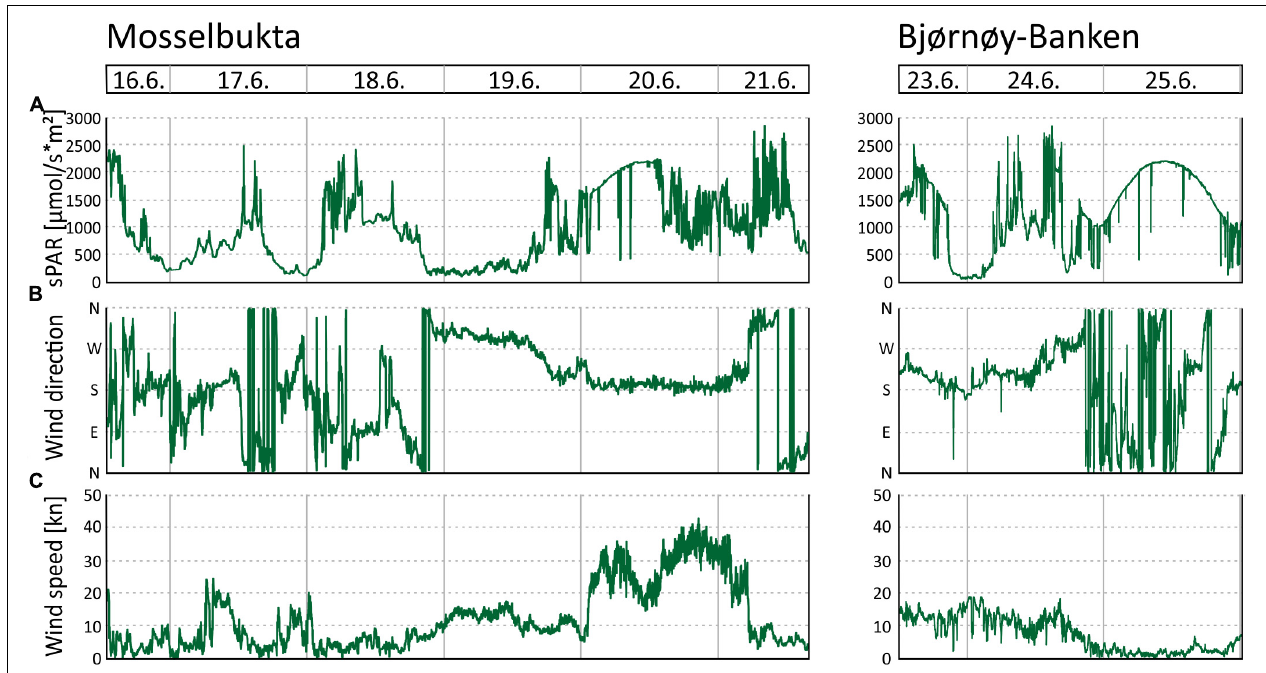
FIGURE 6 | Environmental parameters recorded by the MSM weather station during the period the SaM Lander was deployed at 46 m water depth in Mosselbukta and at Bjørnøy-Banken. (A) Surface level of the photosynthetically active radiation (sPAR). (B) Wind direction. (C) Wind speed.